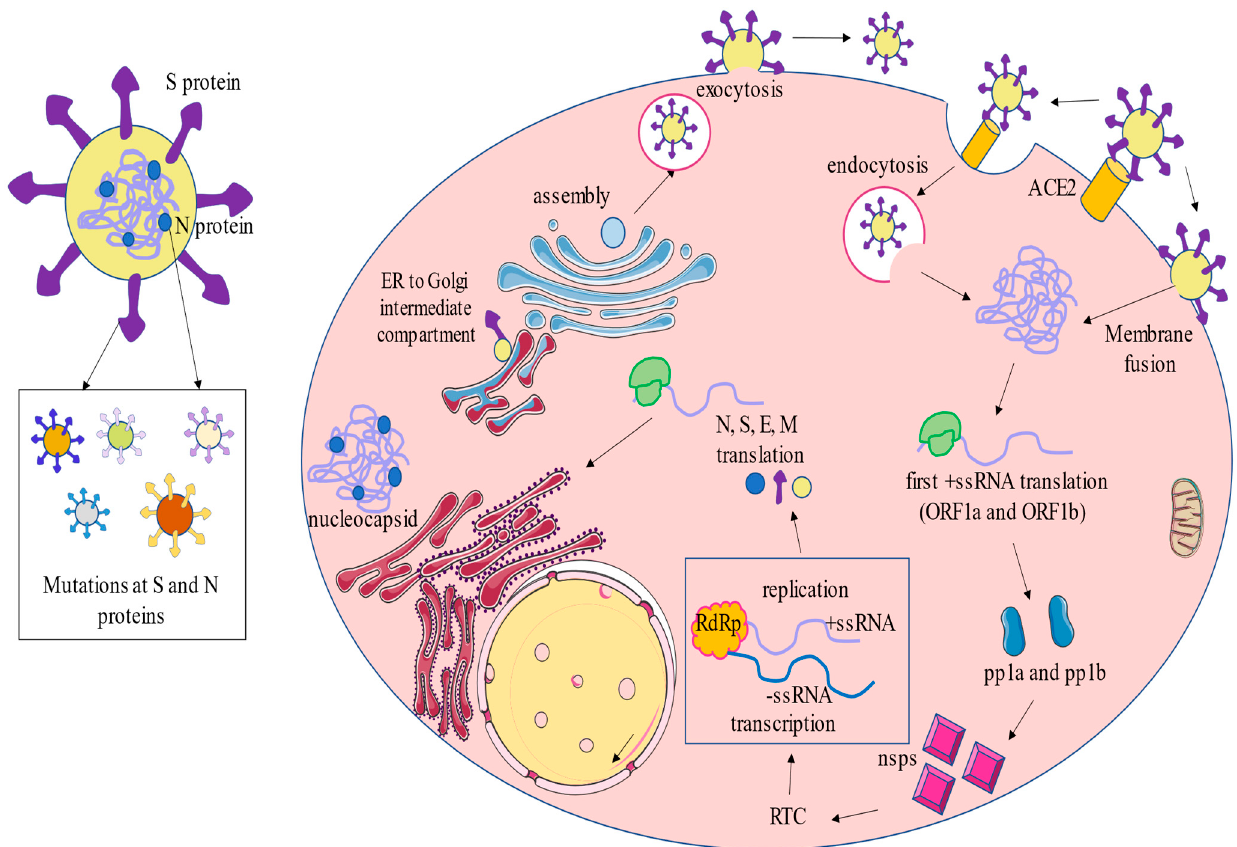
Figure 1. A global picture of SARS-CoV-2 structure and viral cycle. As shown, SARS-CoV-2 is mainly composed by the spike (S), nucleocapsid (N), envelope (E), and membrane (M) proteins, and a +ssRNA. SARS-CoV-2 enters into the cell through the binding of the S protein with ACE2, leading to the formation of endosomes or through membrane fusion. Then, the ssRNA is translated, starting with the open reading frame (ORF) 1a and ORF1b regions codifying polyproteins (pp)1a and pp1b. Through proteolytic cleavage, these polyproteins form 16 nonstructural proteins (nsps), which are related to the replication and transcriptional complex (RTC). In this sense, of note is the role of nsp12, also known as RNA-dependent RNA polymerase (RdRp), in the replication and transcription of the ssRNA. Then, the above-mentioned viral S, N, E, and M proteins are translated and packaged in the endomembranous system, from the endoplasmic reticulum (ER) to the Golgi complex, where it is finally assembled, and a set of viral particles are finally released through exocytosis. Last but not least, it should be highlighted that both S and N proteins can easily mutate during the viral replication cycle. As will be later discussed, this property of the SARS-CoV-2 is directly related to the onset and development of novel variants.